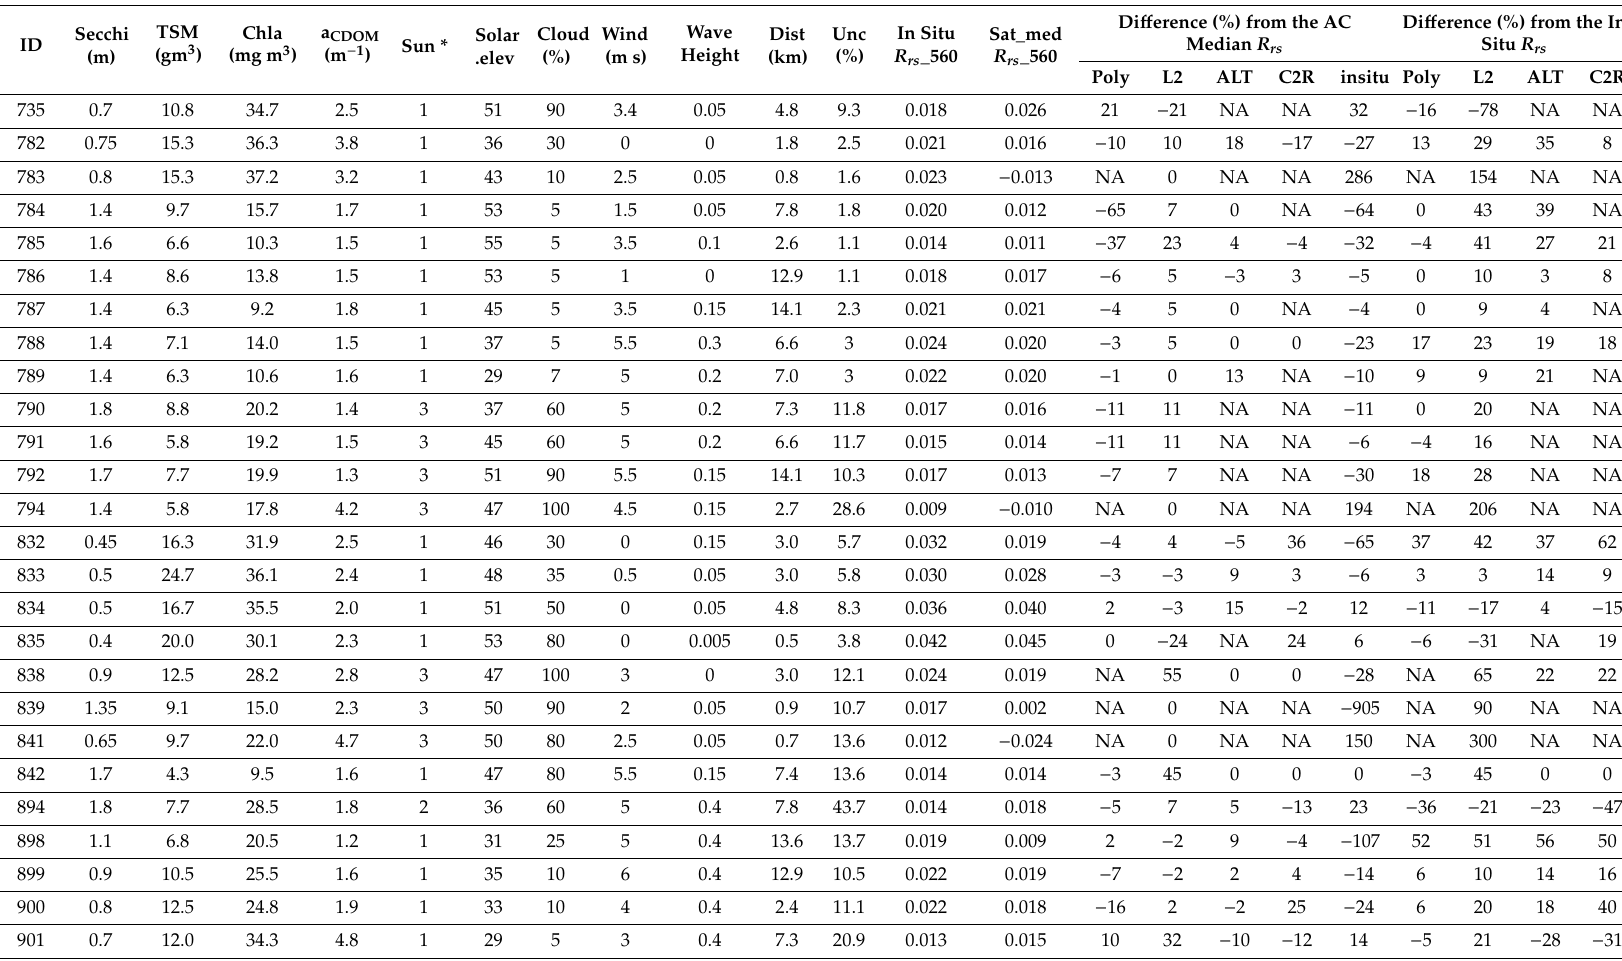
Table A2. Overview of match-up dataset. The bio-optical properties, recorded environmental conditions and radiometric data at the 560 nm band, measured in situ and obtained from tested AC